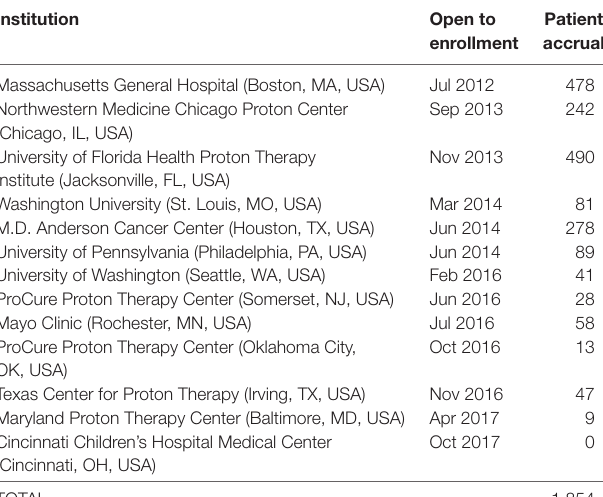
TaBle 1 | Pediatric Proton Consortium Registry patient accrual by institution and date of open